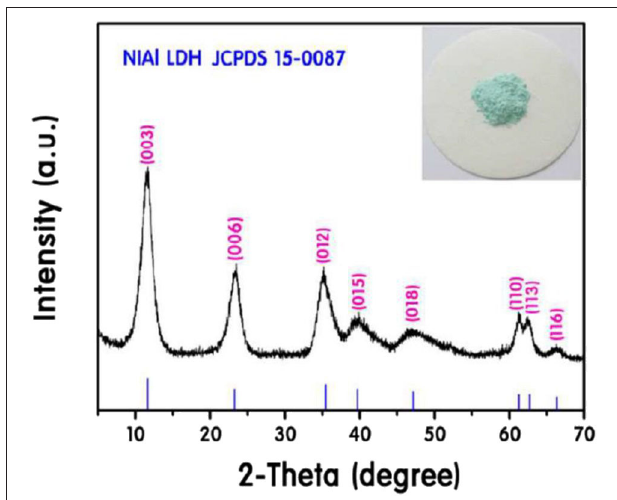
FIGURE 5 | XRD pattern of NiAl (Li et al.,